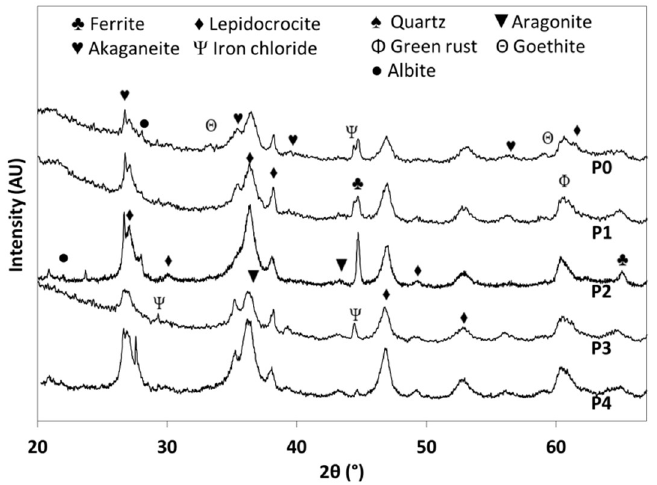
Figure 16. XRD patterns of carbon steel coupons after 241-day exposure in all sites.